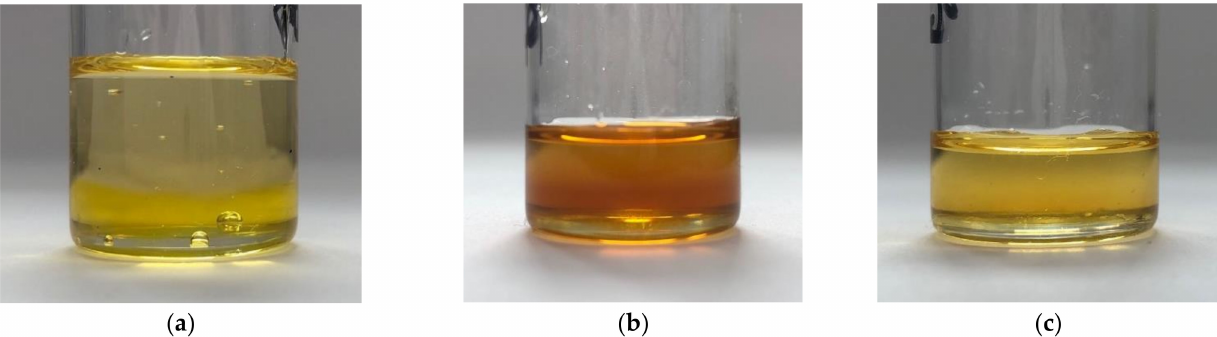
Figure 1. Spinning dopes of chitosan in ionic liquid 1-butyl-3-methyl-imidazolium aceate (BmimOAc) with 6 wt.% solids content: CHS-01 ( a ), CHS-02 ( b ), and CHS-03 ( c